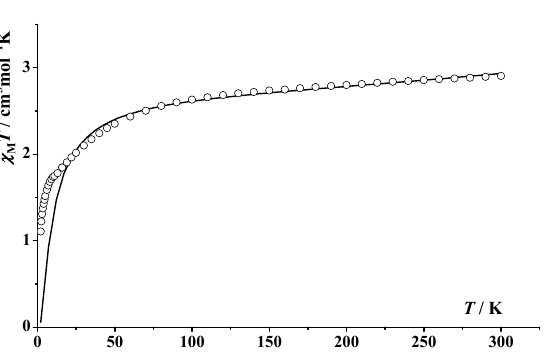
Figure 5. χ M T vs. T Plot for catena -[Co( µ 1,5 -dca) 2 (4-MOP–NO) 2 ] ( 1 ). The solid line shows the best fit obtained (see text).